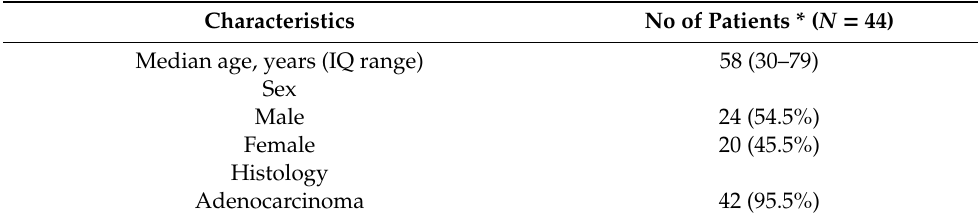
Table 1. Baseline demographics and clinical